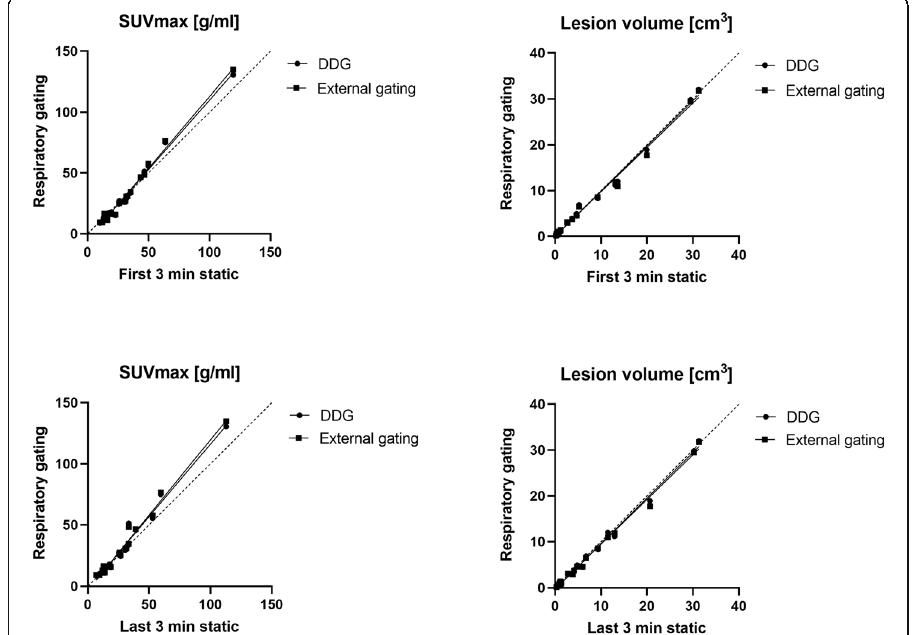
Fig. 3 Correlation plots between gating methods and regular static acquisition for SUV max (left) and lesion volumes based on a 41% SUV max threshold (right). Upper graphs: correlation against static acquisition based on the first 3 min of data acquisition. Lower graphs: correlation against static acquisition based on the last 3 min of data